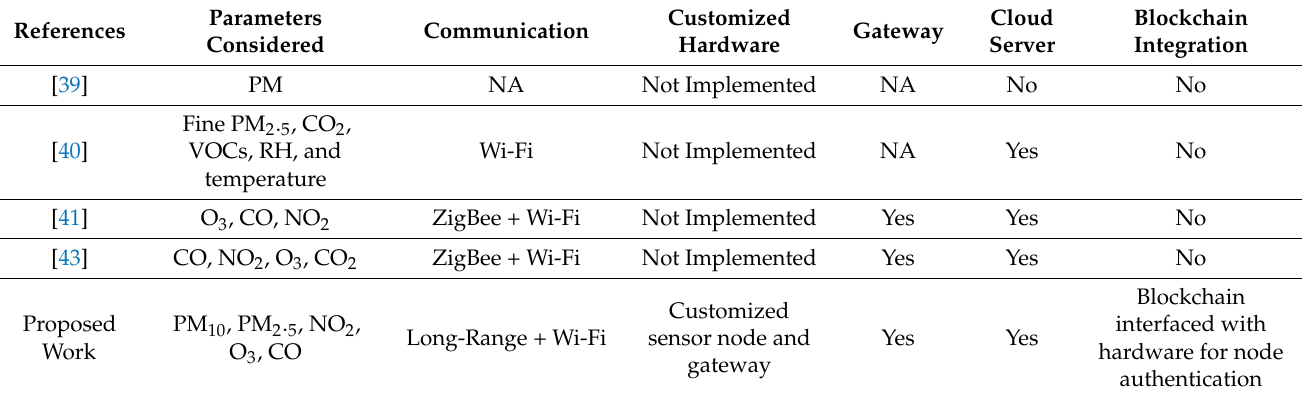
Table 15. Comparison of the previous literature survey with proposed